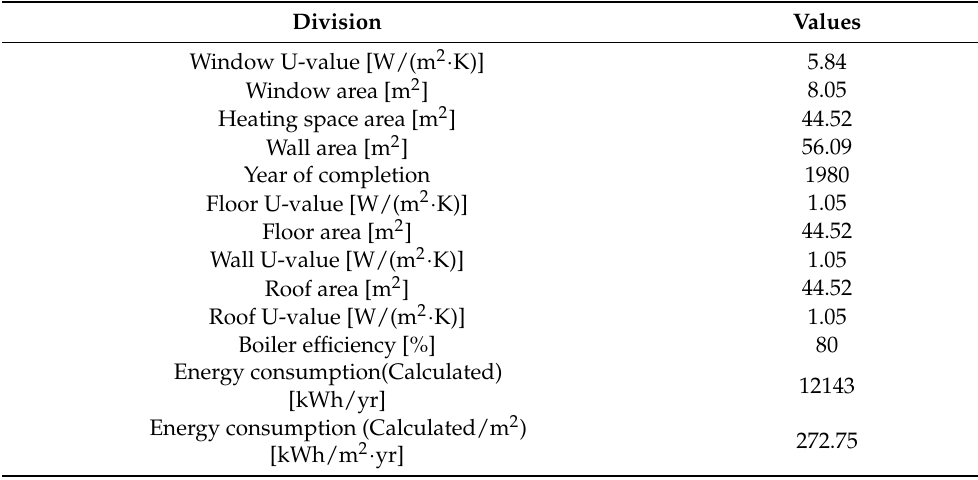
Figure 3. Floor plans of Korean standard house. Table 8. Building Information and heating energy consumption (calculated by EnergyPlus) of standard house.